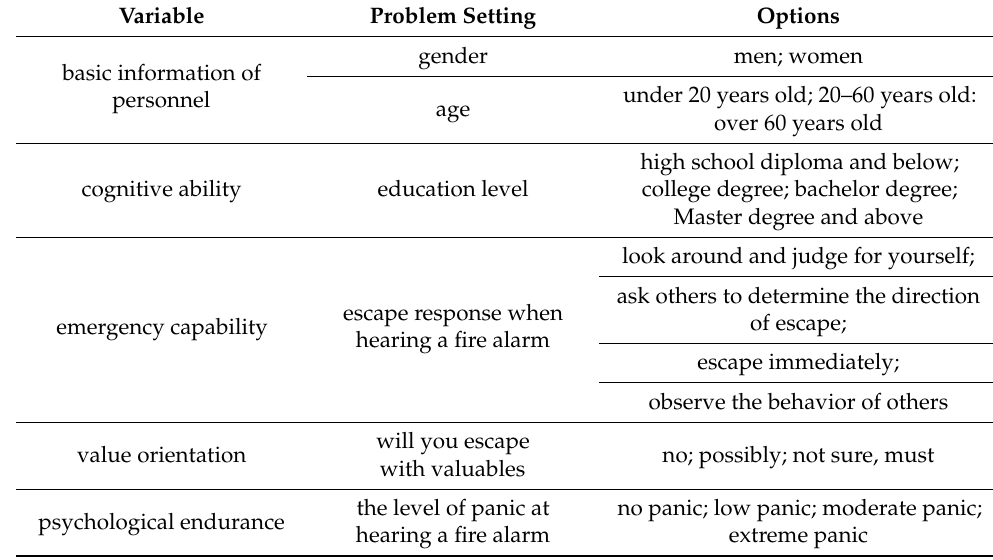
Table 1. Questionnaire structure of personnel evacuation behavior in a ship fire situation.